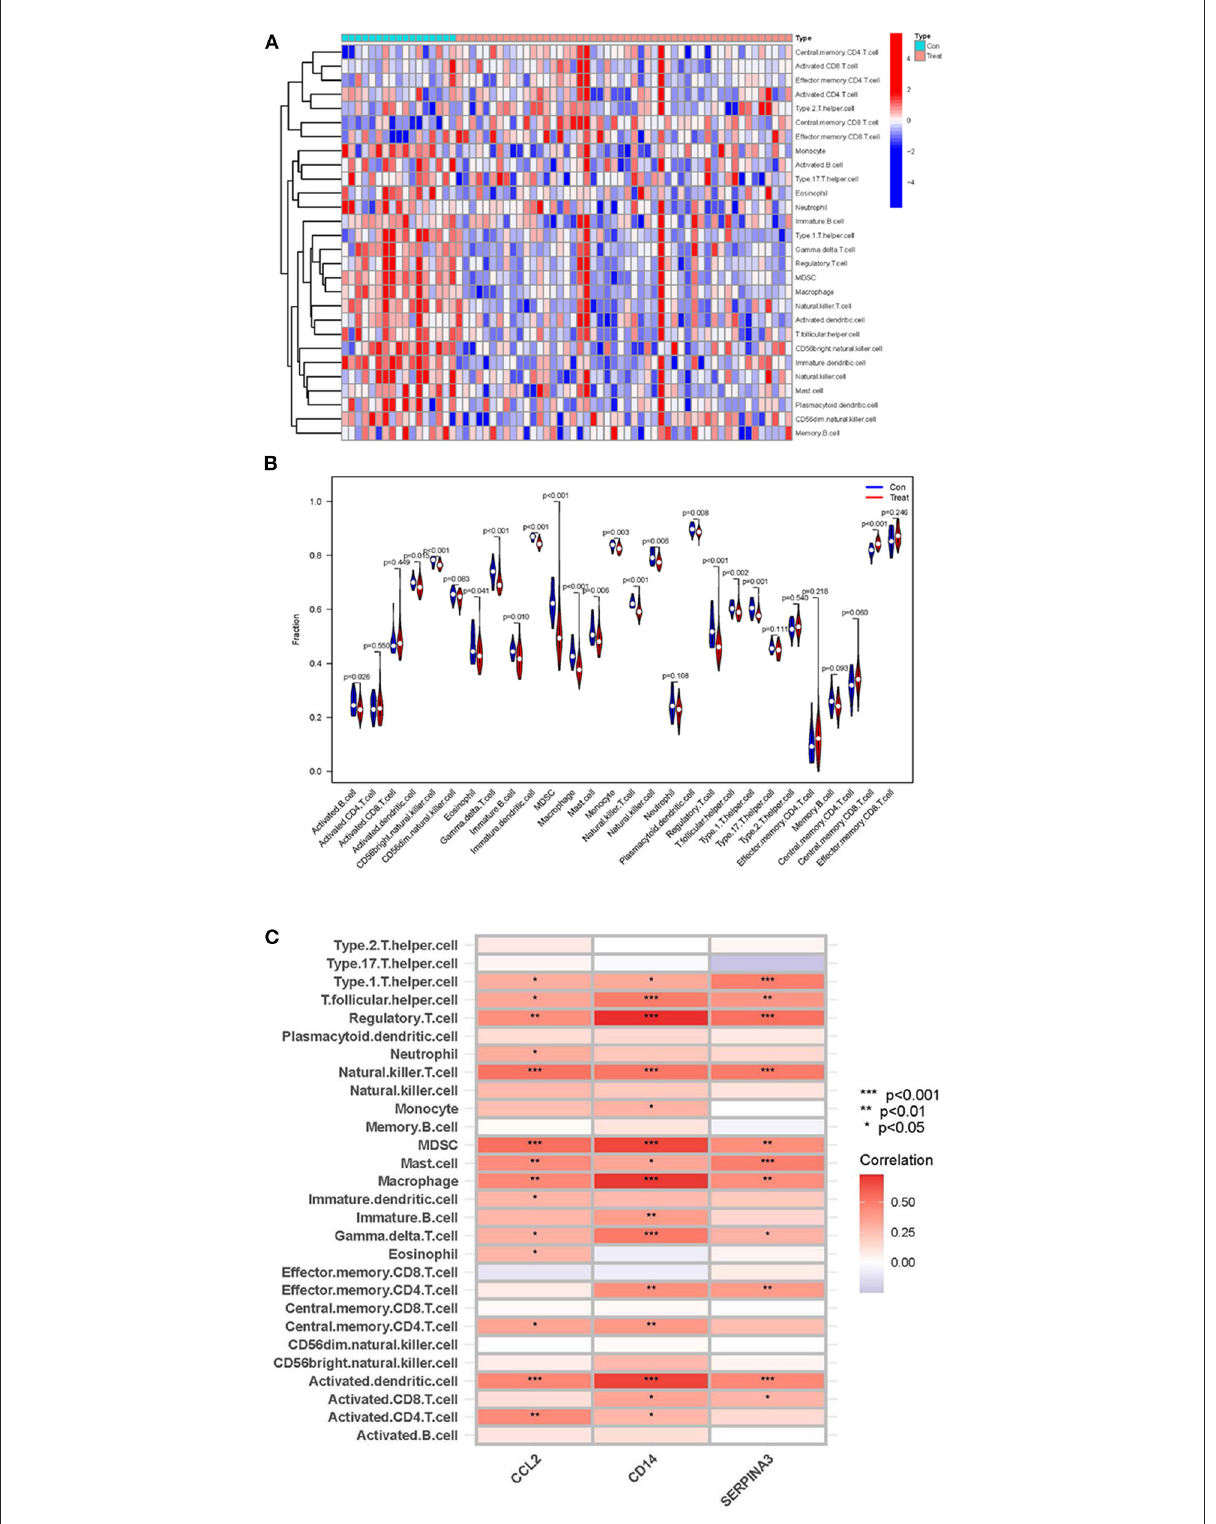
FIGURE9 ssGSEA analysis of immune cell infiltration and its correlation with hub genes. (A,B) Heatmaps and violin plots showing the differences and distribution of 28 immune cells in cardiomyopathy and control groups. (C) The relation between immune cell infiltration and three hub genes; the redder the color, the more significant the difference. “***”, “**”, “*” represent P < (0.001, 0.01,